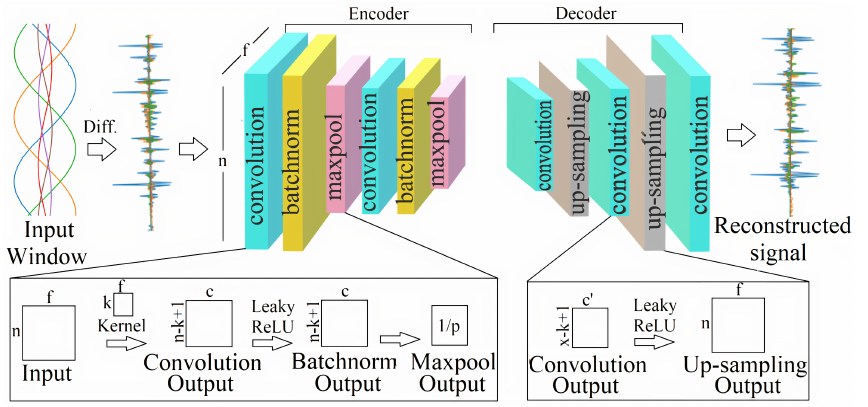
Figure 4. Convolutional autoencoder (CAE)